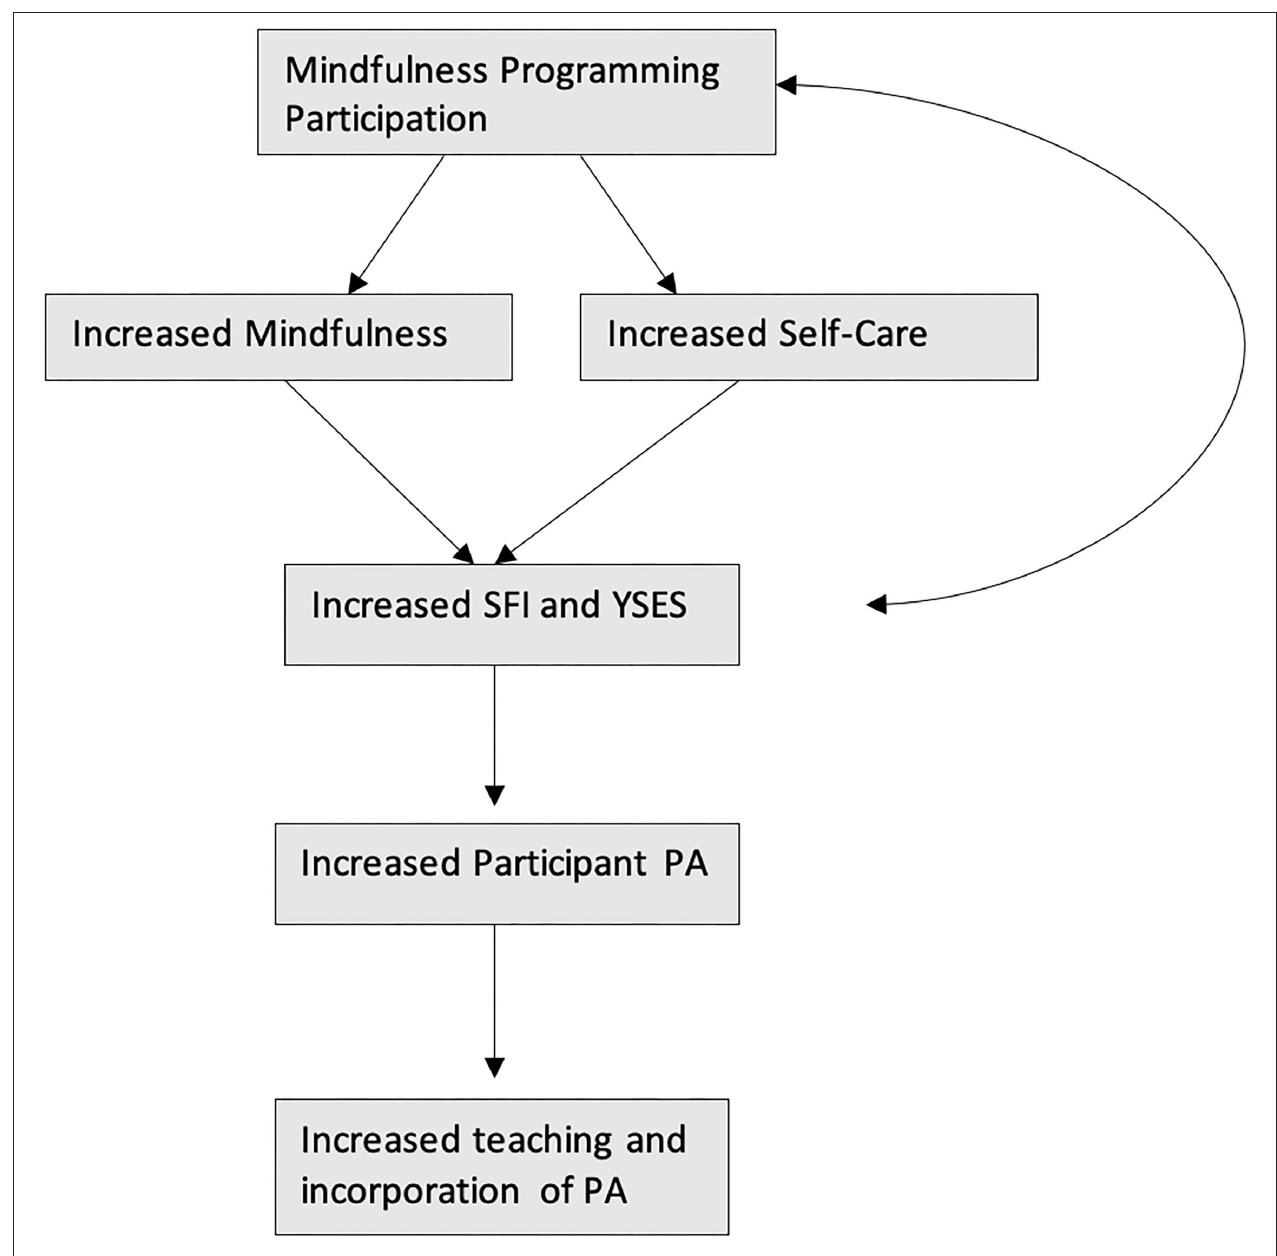
FIGURE 2 | Proposed pathway for increasing mindfulness and